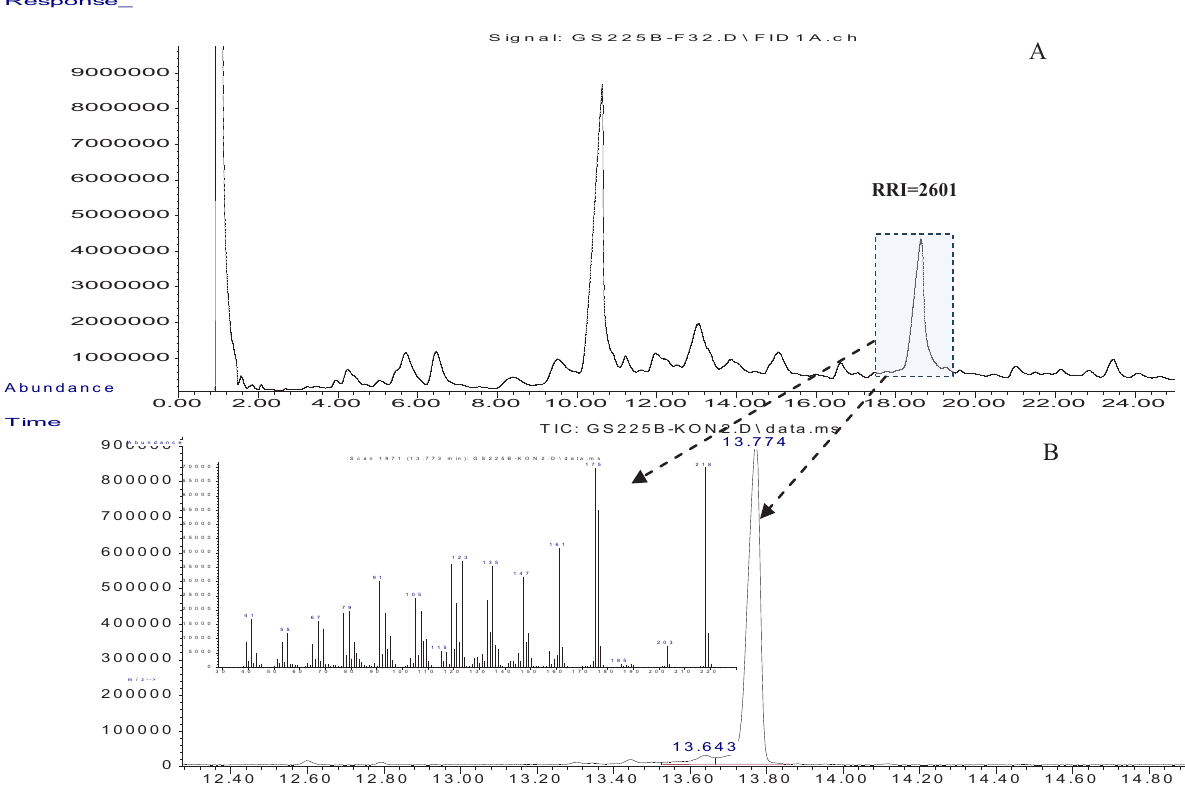
Figure 2. Figure 2: Preparative gas-chromatographic separation with PFC system of the targeted unidentified constituent 1 [M + 218] from P. heyniae EO1. A : The shaded area represents peak selected for trapping by PC-GC technique: between 18.40 min and 19.00 min. B : Control of the isolated constituent for purity using GC-MS and GC/FID. Figure 3: Structure of compound 1 unsaturated ketone system in the structure. The proton and carbon data, secured by COSY, HSQC and HMBC spectra, revealed a characteristic eudesmane-type sesquiterpene framework [62]. Inspection of the COSY spectrum revealed three spin systems: i) H-3 to H -15 and H-5 (allylic coupling) 3